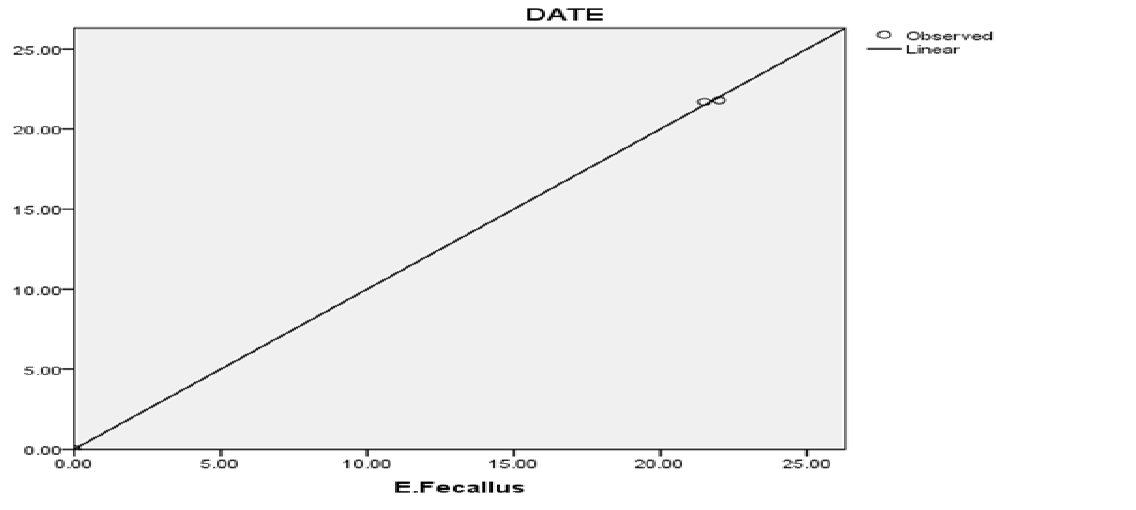
Figure 9. Correlation between treated AC of date’s stones and